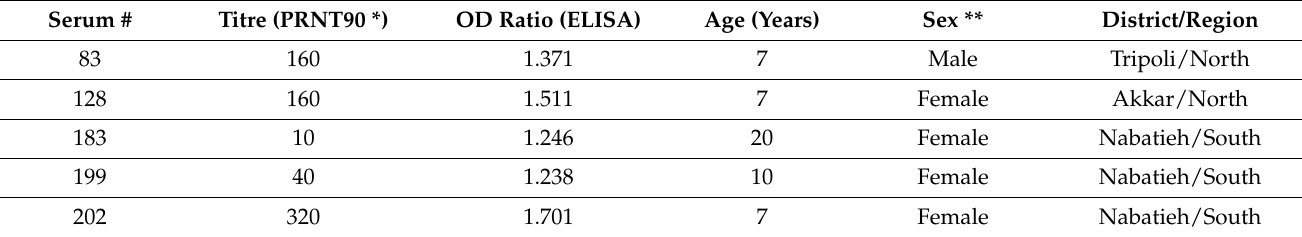
higher (Table 2). All of them were of Alef breed from Tripoli, Akkar in the North, and from Nabatieh, South of the country. None of the animals had a history of cross-border movement but evidence of circulation between different Lebanese districts. In addition, sera of 163 chickens from the Bekaa were tested. Only one had an OD ratio higher than 1.2 with no detected neutralizing antibodies. Table 2. List of seropositive horses that had neutralizing antibodies by PRNT at titers ≥ 10. Serum